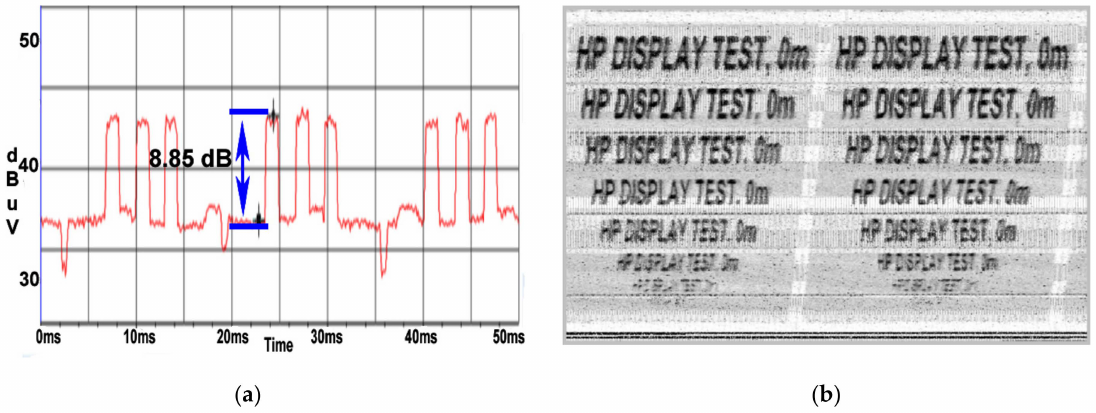
Figure 15. HP display: ( a ) SNR measured at a distance of 0 m; ( b ) image recovered at a distance of 0